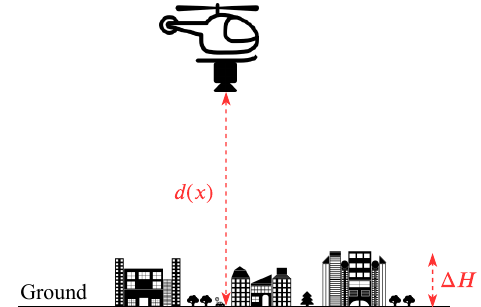
Figure 2: Depth of the pixels ( d ( x ) ) and the height variations on the ground ∆ H in aerial imagery (note that ∆ H (cid:28) d ( x )